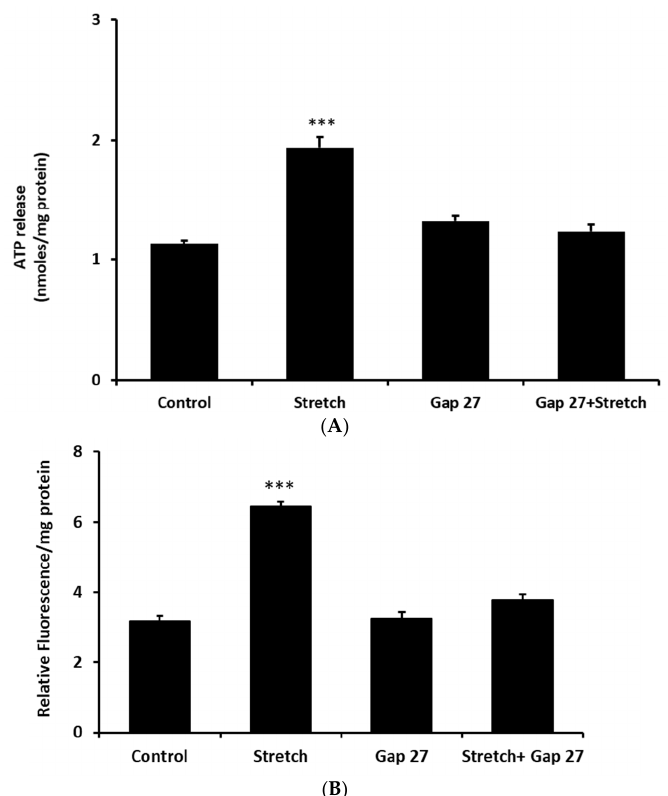
Figure 5. The ATP release and propidium iodide uptake responses to cyclic stretch were abolished by the connexin mimetic peptide Gap 27. The amount of ATP in the bathing medium and PI in cell lysate were measured after subjecting the monolayers of cultured NPE cells to 10% cyclic stretch (0.5 Hz) for 2 min in the presence of Gap 27 (200 µ M) added 60 min beforehand. ( A ) shows effect on ATP response and ( B ) shows effect on PI uptake response. The data are the mean ± SE of results from six independent experiments. *** ( p < 0.001) indicates significant differences from